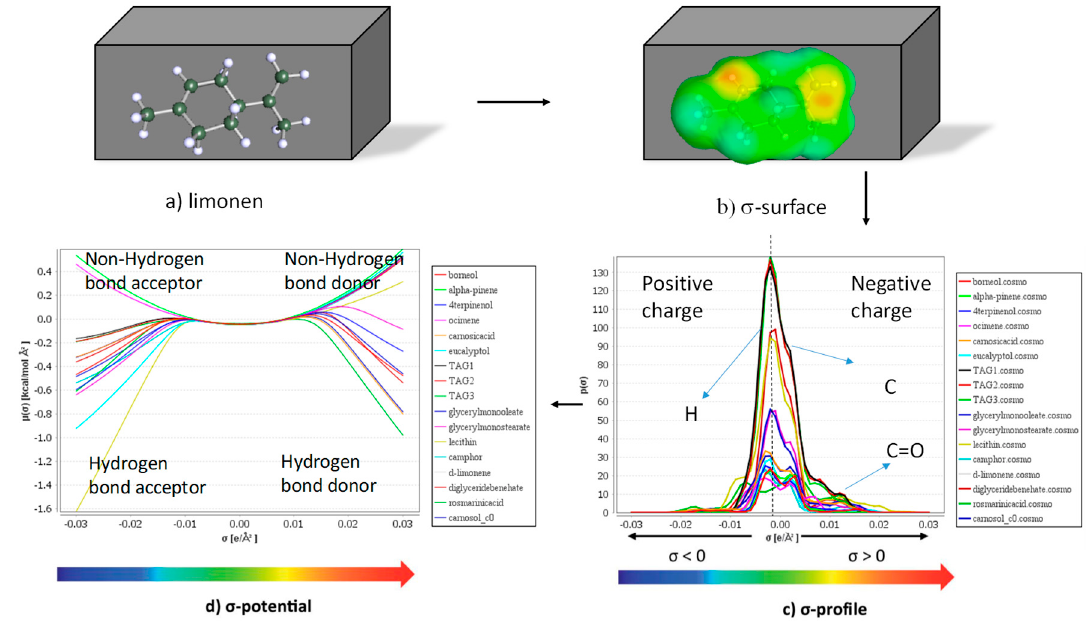
Figure 2. Schematic COSMO-RS (COnductor like Screening MOdel for Real Solvents) step-wise procedures.